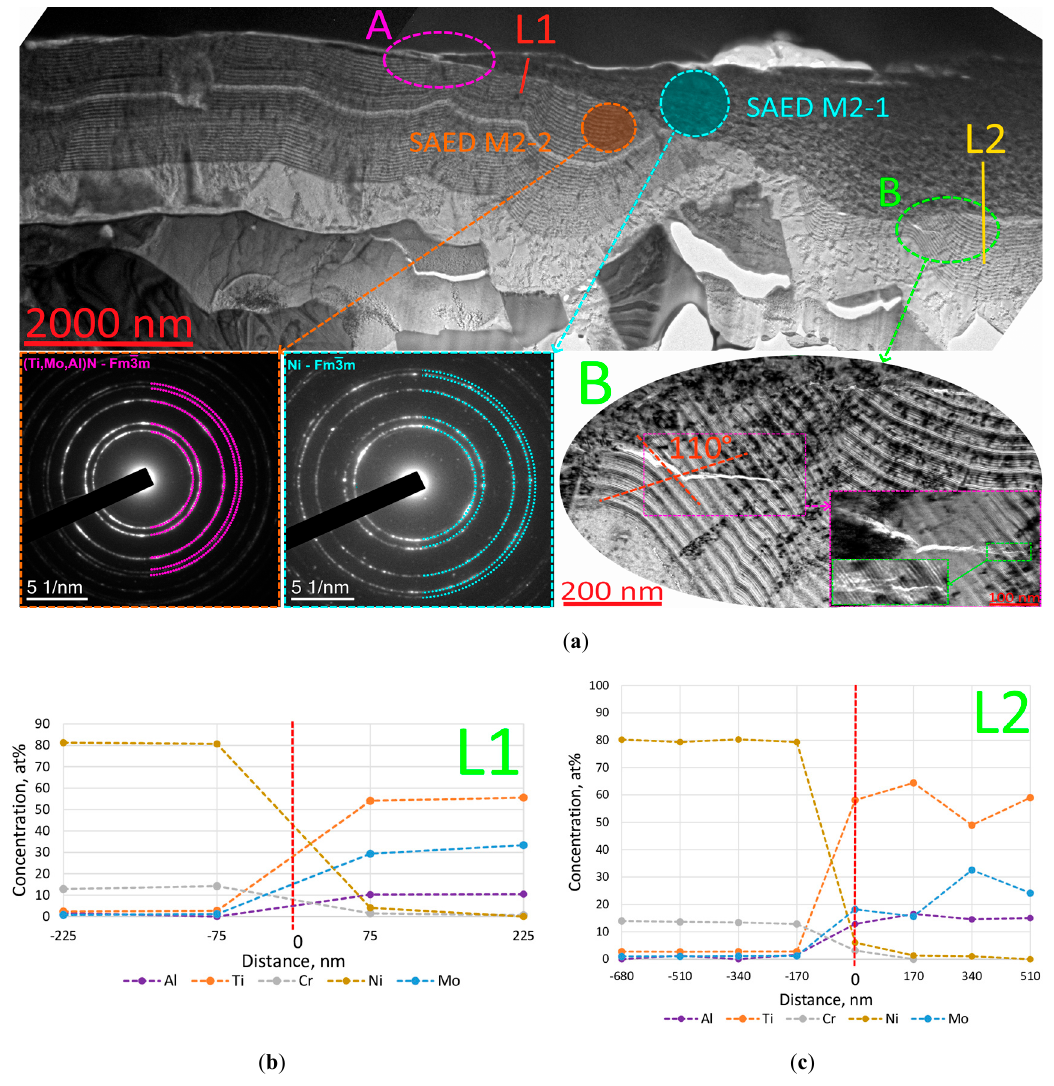
Figure 7. ( a ) General view of the lamella under consideration with the localization of areas for further study, lines of the elemental composition analysis, SAED areas, and results of the analysis of SAED obtained; ( b ) analysis of distribution of elements along line L1; ( c ) analysis of distribution of elements along line L2. The localization of area B and the lines of study of the elemental composition L1 and L2 are shown in ( a